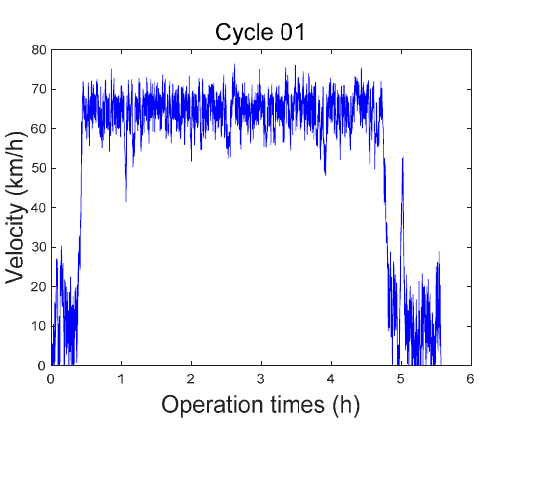
Figure 7. Transition probability map of highway conditions.